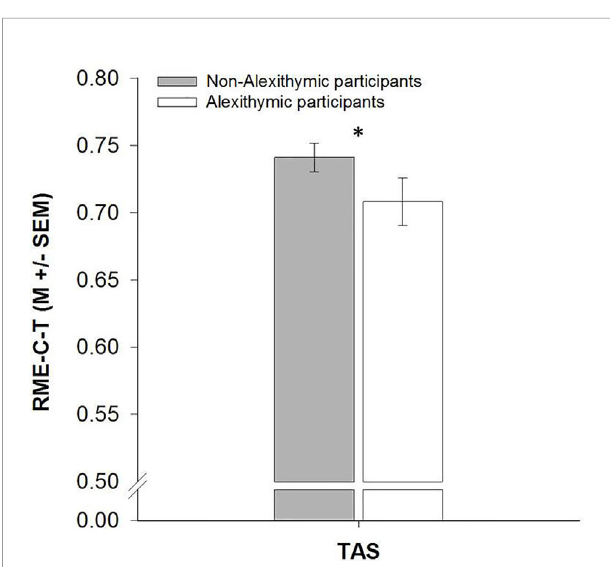
FIGURE 5 | Barplots demonstrating differences in Reading the Mind in the Eyes of Children [RME-C-T, (23)] performance between participants with high and low scores on the Toronto Alexithymia Scale [TAS, (28,